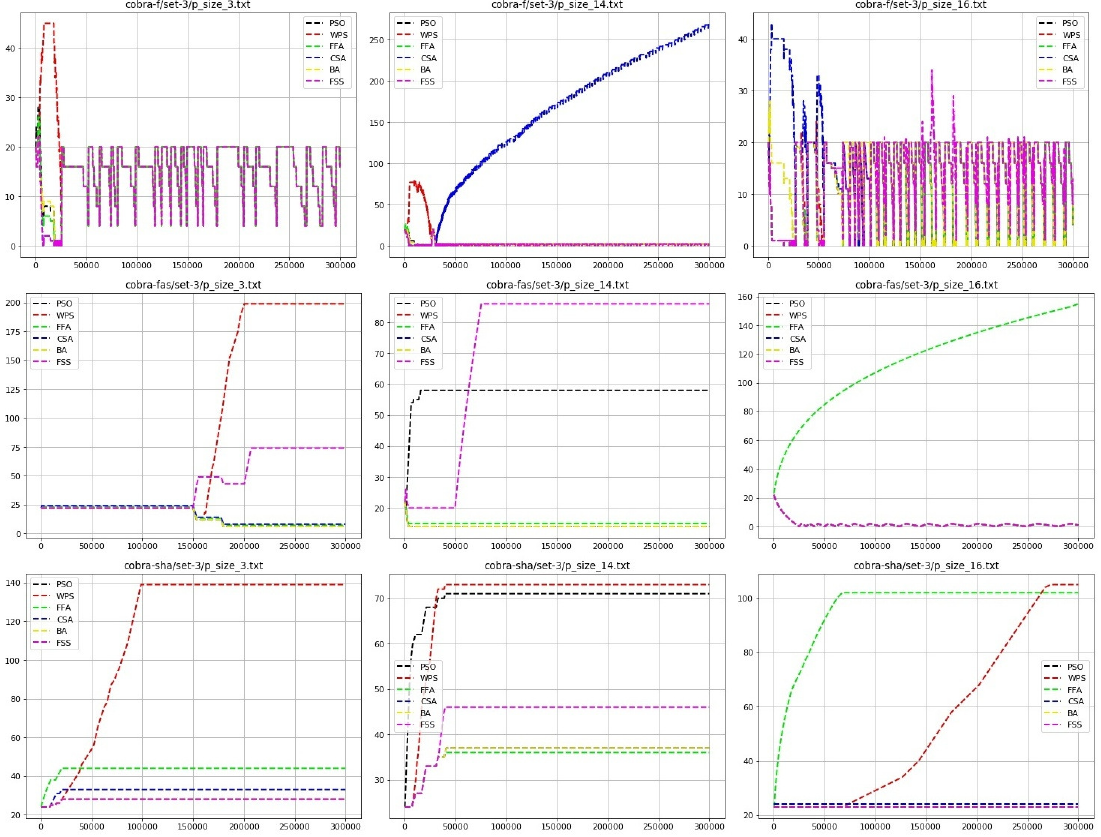
Figure 12. Population size changes for